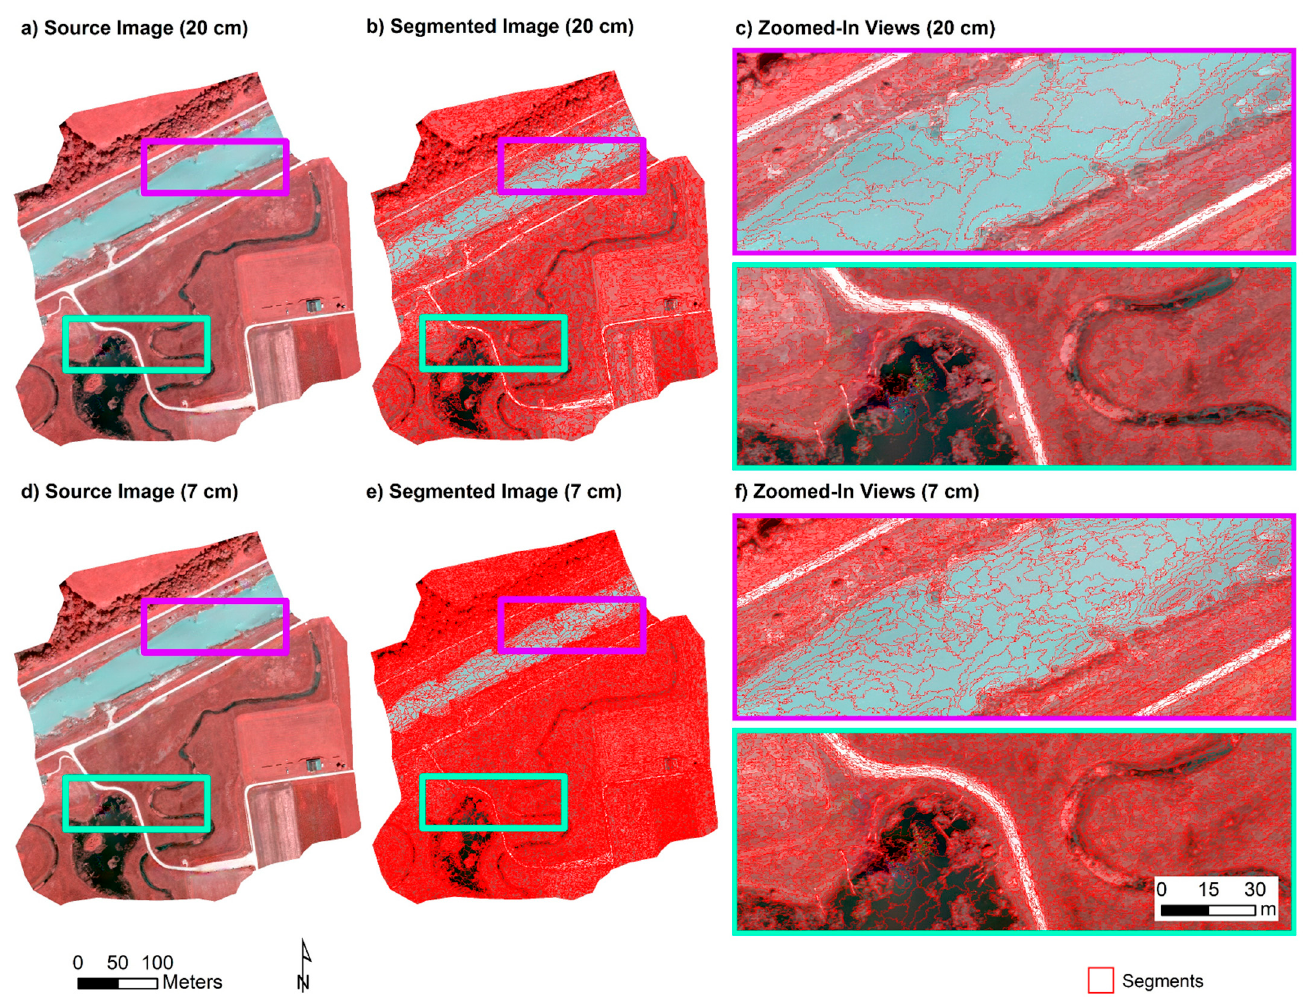
Figure 5. ( a ) Narrow-band image from 29 July 2016 of the River Gail study area with 20 cm spatial resolution (bands 797, 670, and 550 nm as R,G,B); ( b ) Image segments generated using eCognition ® for the 20 cm narrow-band image; c ) Zoomed-in views to the source image and segments depicted by the purple and cyan rectangles in ( a ) and ( b ); ( d ) Narrow-band image from 29 July 2016 of the River Gail study area with 7 cm pixel size; ( e ) Image segments generated using eCognition ® for the 7 cm narrow-band image; ( f ) Zoomed-in views to the source image and segments depicted by the purple and cyan rectangles in ( d ) and ( e ).